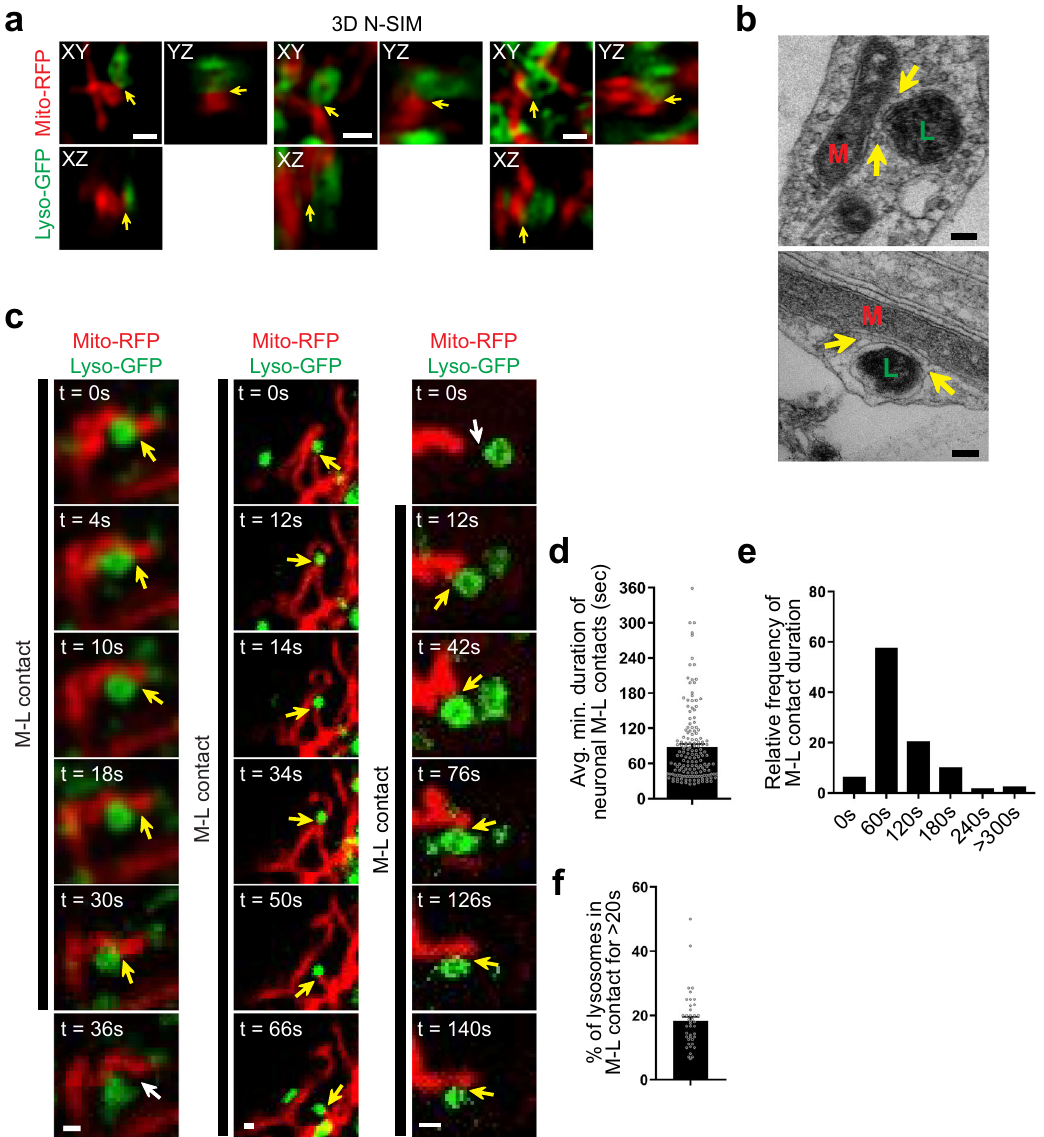
Fig. 1 Mitochondria – lysosome contacts dynamically form in human neurons. a Representative 3D structured illumination microscopy (N-SIM) images of M – L contacts (yellow arrows) in wild-type human dopaminergic iPSC-derived neurons (mitochondria: red, Mito – RFP; lysosomes: green, Lyso-GFP) (30 neurons from N = 3 independent experiments were imaged). b Representative electron microscopy (EM) images of M – L contacts (yellow arrows) with distance between membranes <10 nm (mitochondria, M; lysosomes, L). c Representative time-lapse confocal images of dynamic contacts between mitochondria (red, Mito-RFP) and lysosomes (green, Lyso-GFP). Time-lapse recordings were taken at 2 s intervals for 3 – 5 min. Yellow arrows mark stable M – L contacts. White arrows mark the site of M – L contacts before contact formation or after contact untethering. Black line shows duration of contacts (see Supplementary Movies 1 and 2). d , e Quanti fi cation of duration of stable M – L contacts from confocal images ( n = 156 contacts from 26 neurons, N = 3 independent experiments). d Average minimum duration of neuronal M – L contacts. e Relative frequency (percentages) distribution of neuronal M – L contacts. X -axis represents bin centers. Bin width = 60 s. f Percentage of lysosomes contacting mitochondria (for >20 s) ( n = 41 neurons, N = 3 independent experiments). For all quanti fi cations, data are means± S.E.M. Scale bars, 500 nm ( a , c ); 100 nm ( b